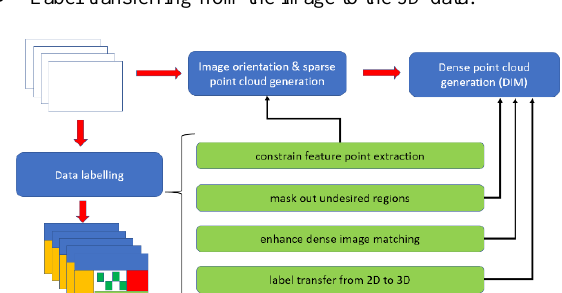
Figure 2: The proposed semantic photogrammetric pipeline where semantic segmentation using deep learning methods are implemented to support 3D results.